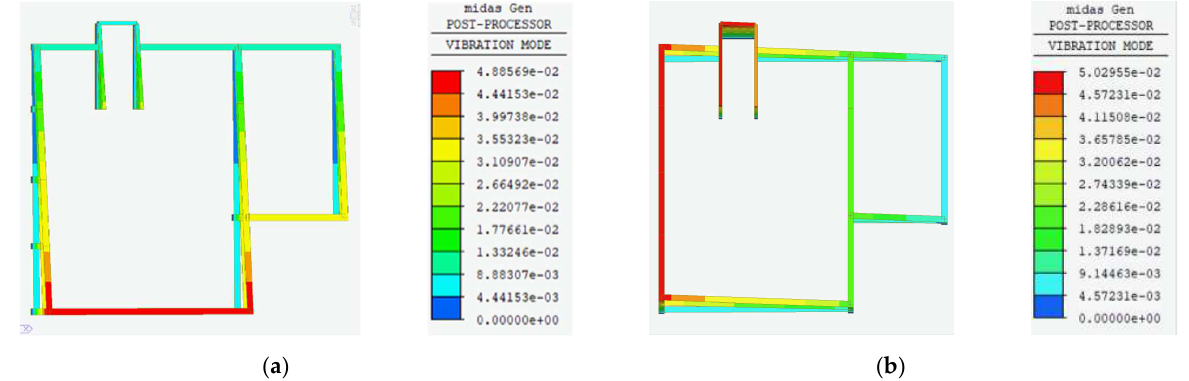
Figure 5. Modal deformations of unit A: ( a ) in the X direction (mode 1); ( b ) in the Y direction (mode 4). The colour scale identifies displacement values.